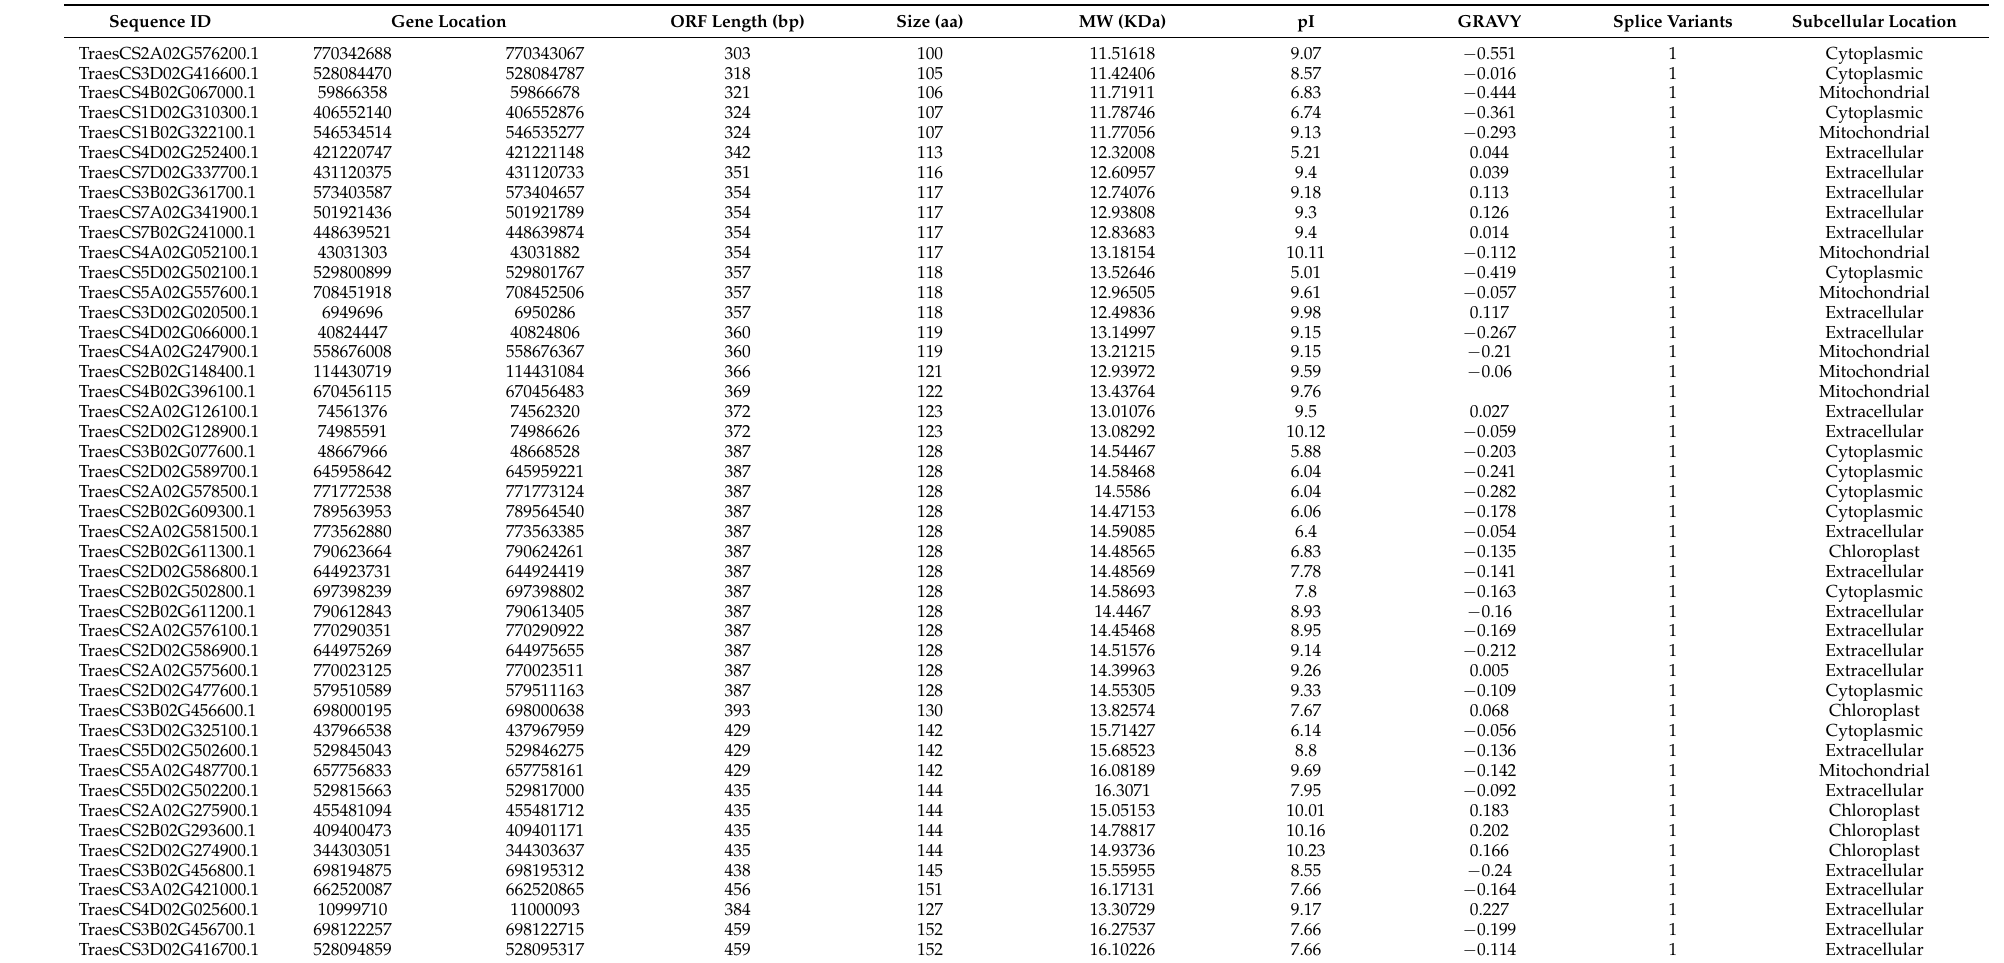
Table 1. Detailed information of the putative cystatin proteins in bread